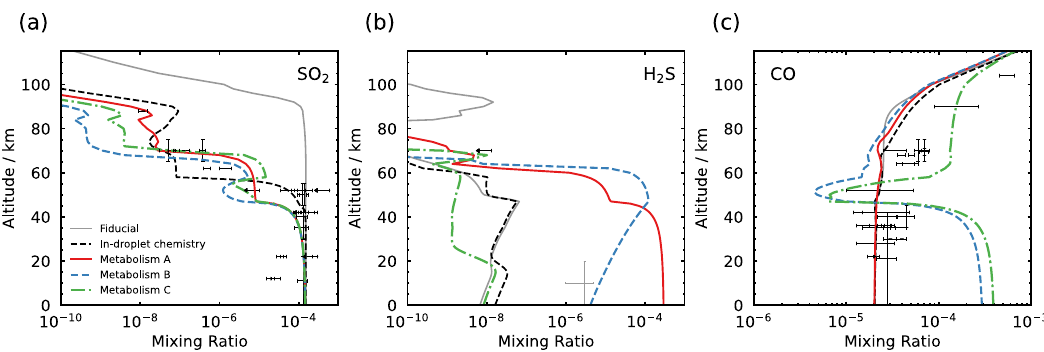
Fig. 2 Atmospheric pro fi les resulting from biochemical SO 2 -depletion. Atmospheric pro fi les of ( a ) SO 2 , ( b ) H 2 S and ( c ) CO mixing ratios as a function of altitude for the Rimmer et al. models (with and without droplet chemistry) 6 , compared with the three proposed metabolic pathways 20,21 under conditions that reproduce the SO 2 observations. Observational data and their 1 σ errors are shown in black except for the observation of H 2 S below 20 km altitude which is shown in grey, as this is possibly a spurious detection 35